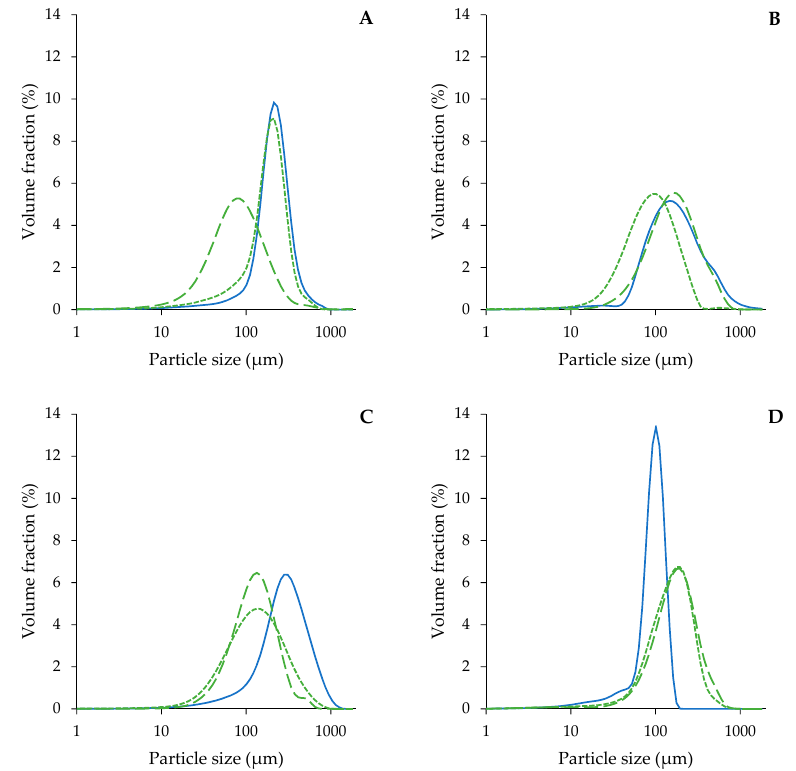
Figure 3. Volume-based particle size distribution of the suspensions prepared with the acid-unextractable fraction of apple ( A ), carrot ( B ), onion ( C ) and pumpkin ( D ) before (solid blue line) and after high-pressure homogenization at 20 MPa (green short dashed line) and 80 MPa (green long dashed line).